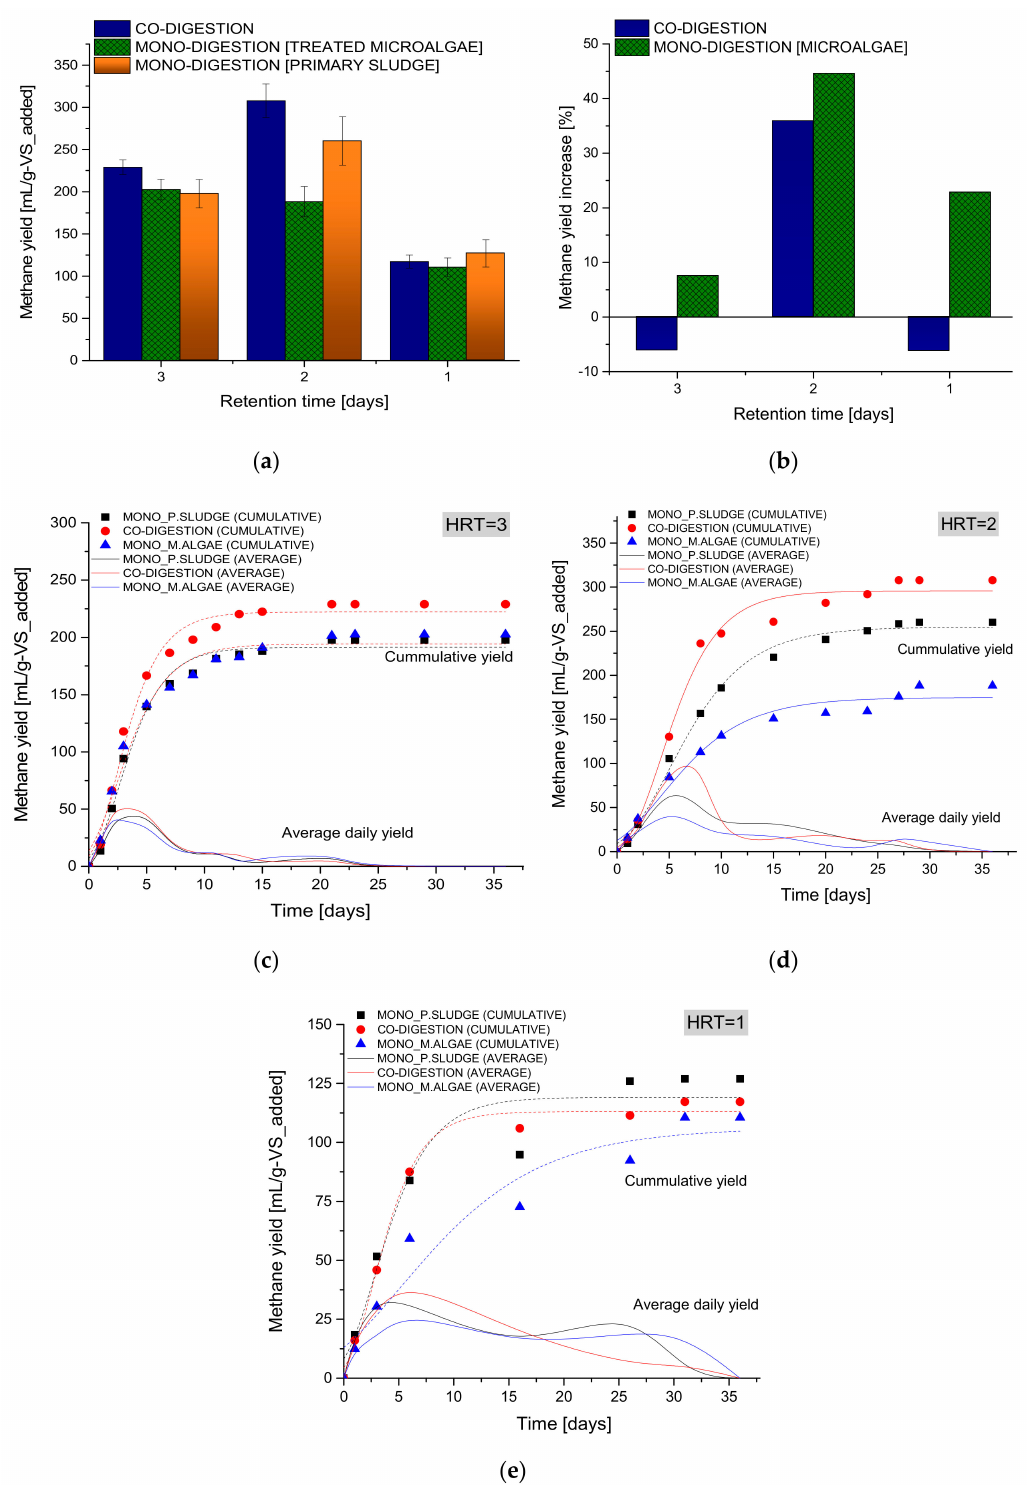
Figure 3. Methane yield at di ff erent HRTs after aerobic biological pretreatment: ( a ) experimental maximum yield; ( b ) percentage increase in methane yield as compared to no pretreatment condition; ( c – e ) experimental vs. simulated values at di ff erent HRTs [Experimental condition: Mesophilic AD temperature = 35 ◦ C, Sludge / algae ratio for co-digestion = 9, pH = 7.1 ± 0.2, ISR = 2, Working AD volume = 150